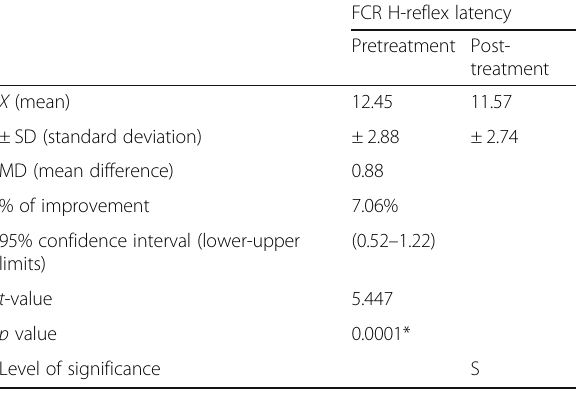
Table 2 Comparison between pre- and post-treatment values of flexor carpi radialis H-reflex